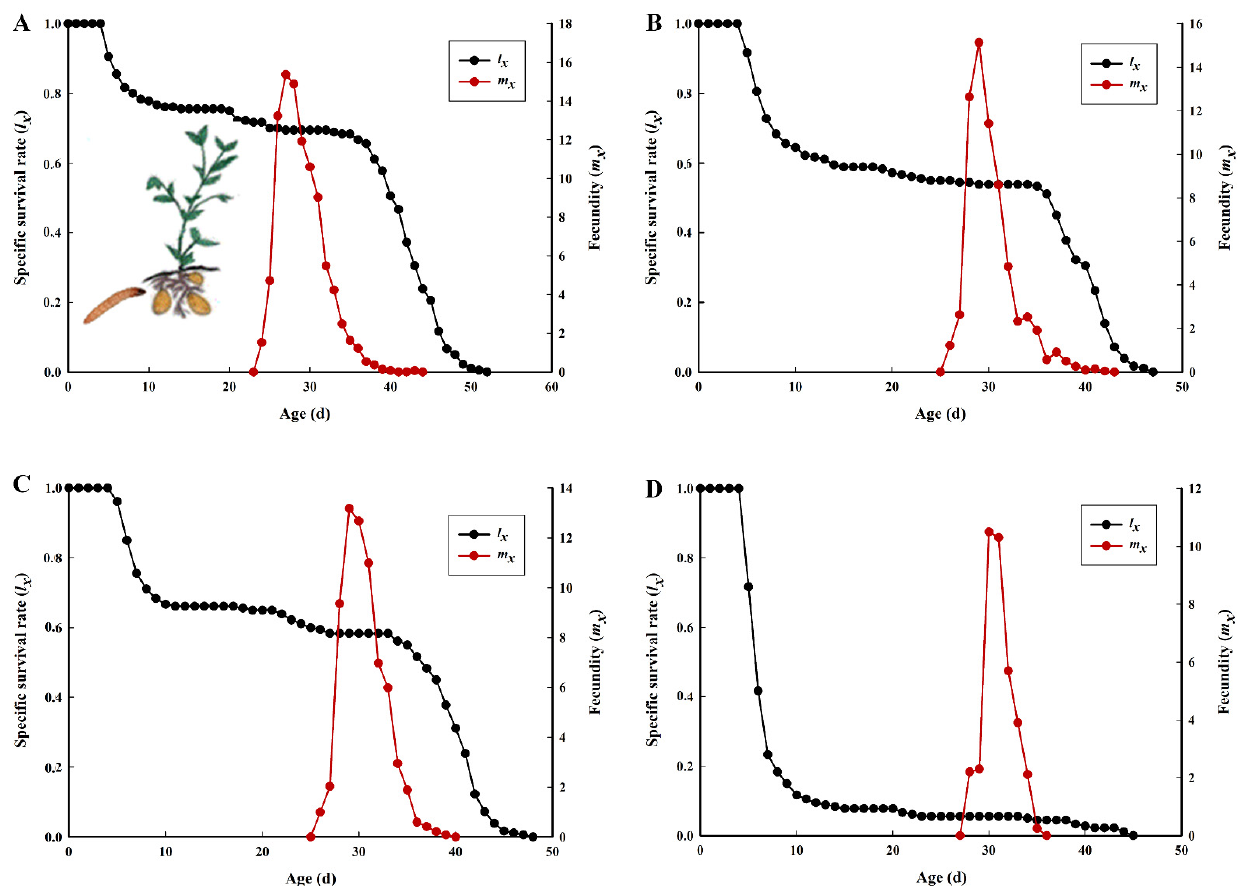
Figure 2. Age-specific survival rate ( l x ) and fecundity ( m x ) of P. operculella on four different potato tuber varieties. ( A ): Lishu 6; ( B ): Hezuo 88; ( C ): Yunshu 304; ( D ): Qingshu 9.